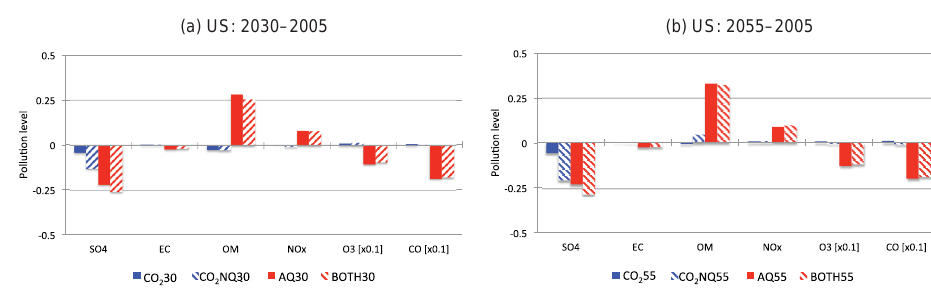
Figure 4. Same as Fig. 2 but for the difference between ModelE2-TOMAS and ModelE2-OMA. See Table S3 in the Supplement for the exact values for